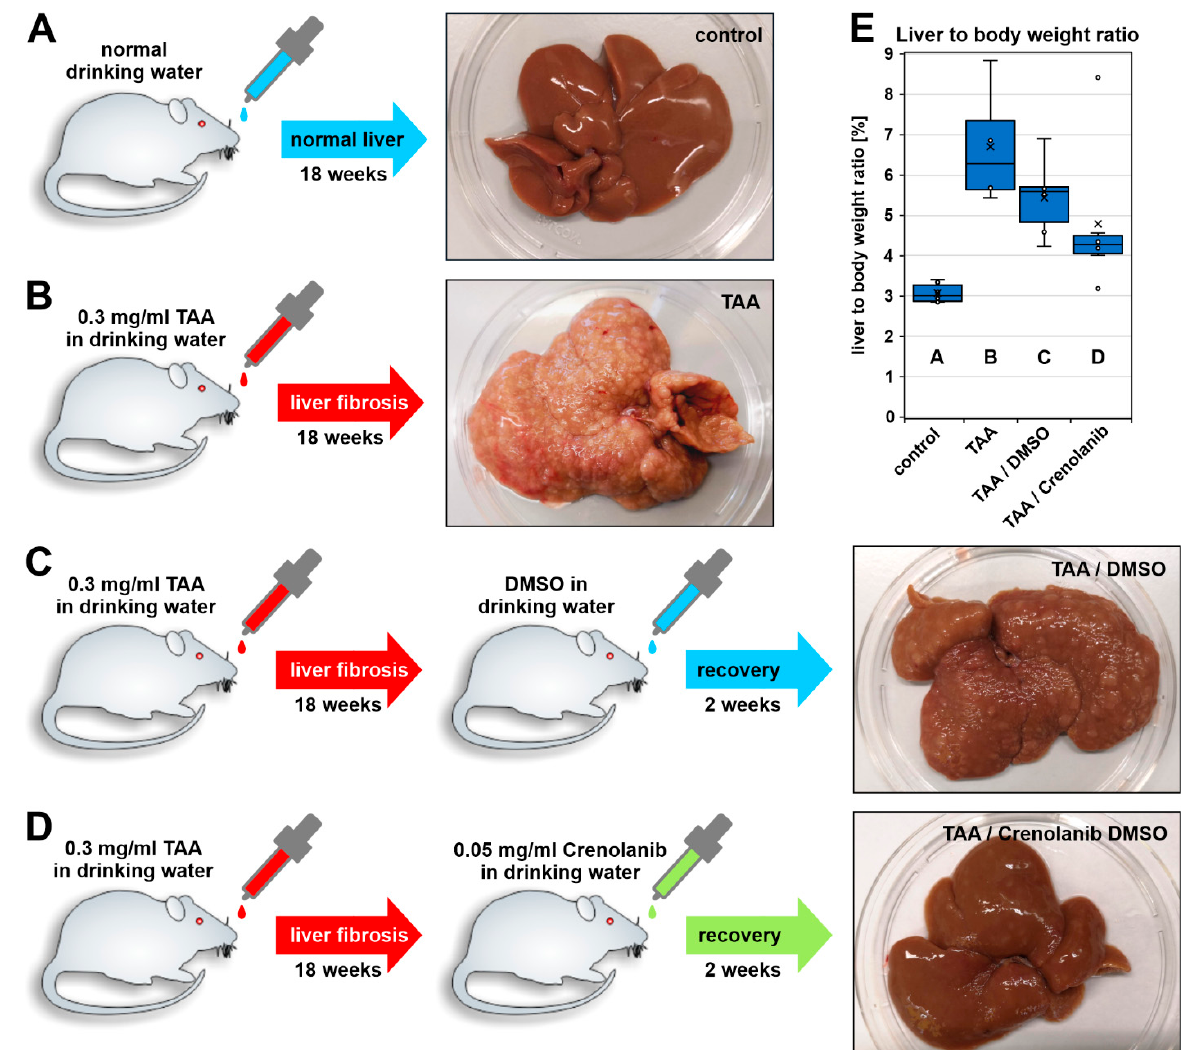
Figure 1. Experimental setup of the TAA-induced liver fibrosis model in rats. Rats were treated with 0.3 mg/mL thioacetamide (TAA) for 18 weeks via drinking water to induce liver fibrosis. ( A ) The control group received normal water and showed no changes in liver morphology, ( B ) the TAA-treated group exhibited the typical nodular liver surface characteristic of the fibrotic liver. ( C and D ) The livers were allowed to recover from liver fibrosis after the cessation of TAA treatment in the absence and presence of Crenolanib (0.05 mg/mL) for 14 days. ( C ) The control group with fibrosis was treated with an equal volume of the vehicle, dimethyl sulfoxide (DMSO), which was used as a solvent for Crenolanib. ( C and D ) Comparison of the liver morphology indicated accelerated liver regeneration in ( D ) the Crenolanib-treated group. ( E ) Improved recovery from fibrosis in the presence of Crenolanib was also indicated when the ratio of the liver to the body weight was determined (cross: arithmetic mean; line: median; boxes: 50% of the data; A : n = 6; B : n = 4; C and D : n = 6).